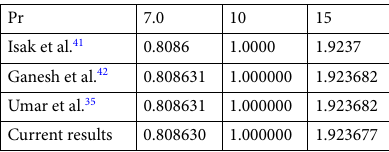
θ ′ ( 0 ) values for different Prandtl numbers. −